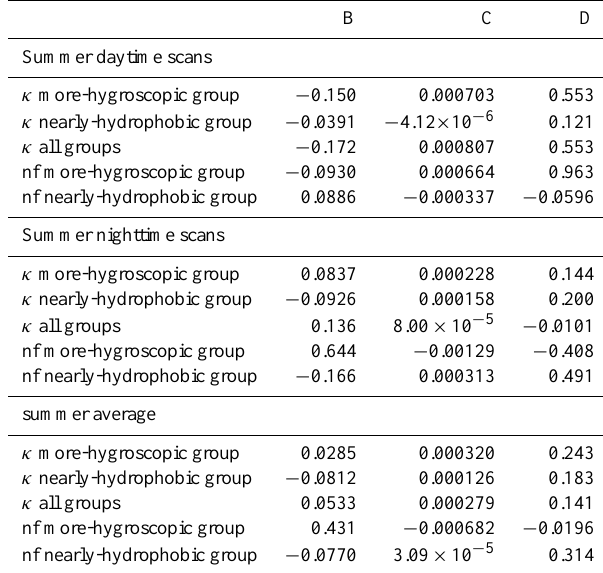
Table 2. Summary of fitting parameters for the parameterization of κ and nf; see Eq. (2) and Sect. 3.4 for